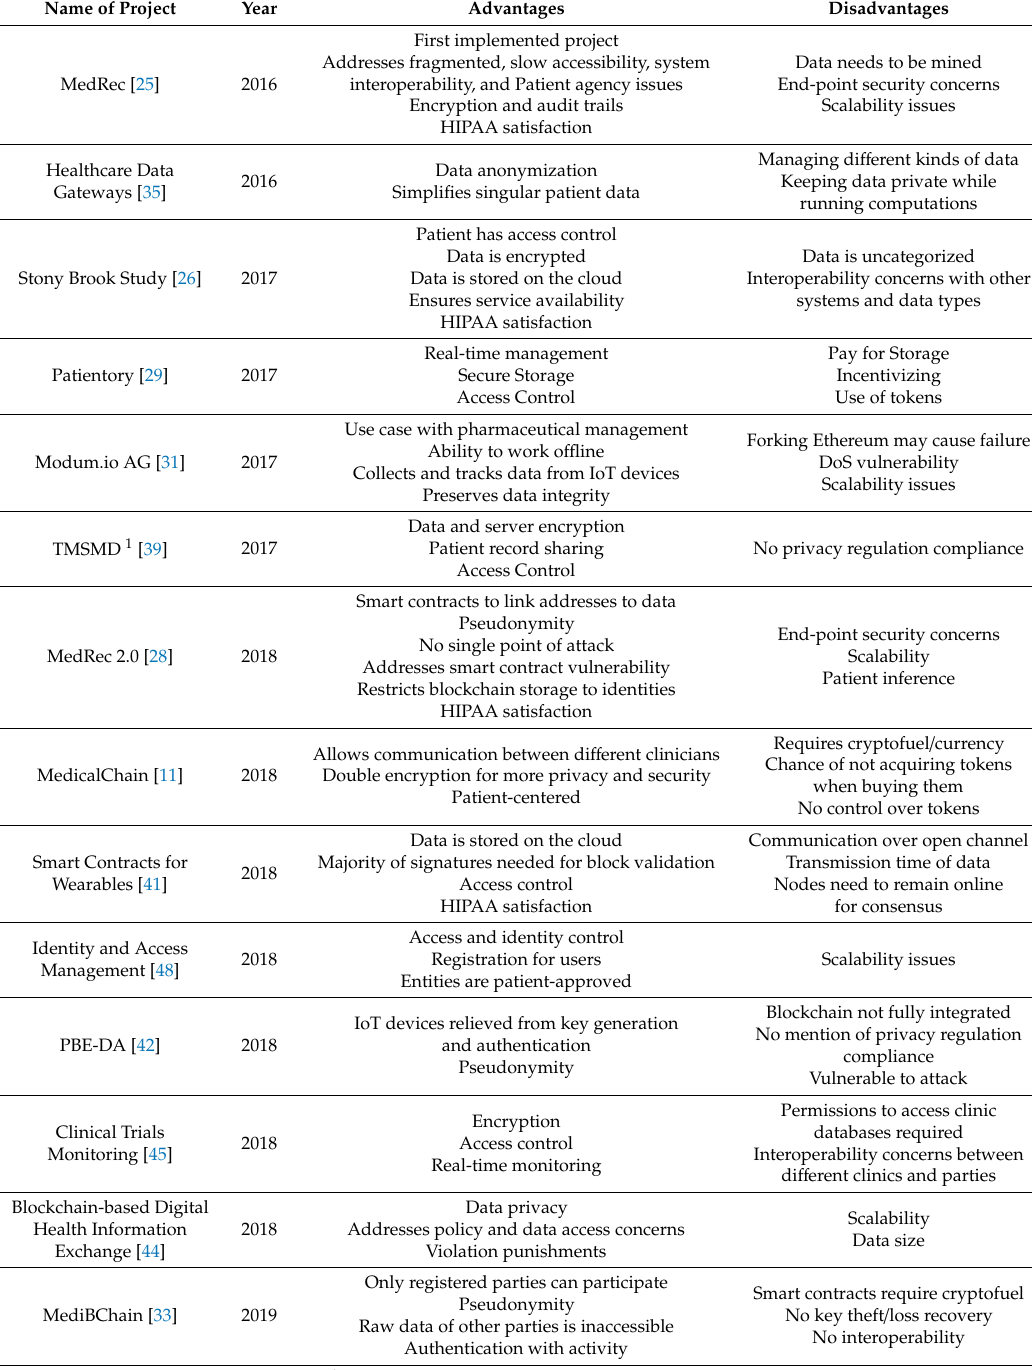
Table 4. A summary of the reviewed